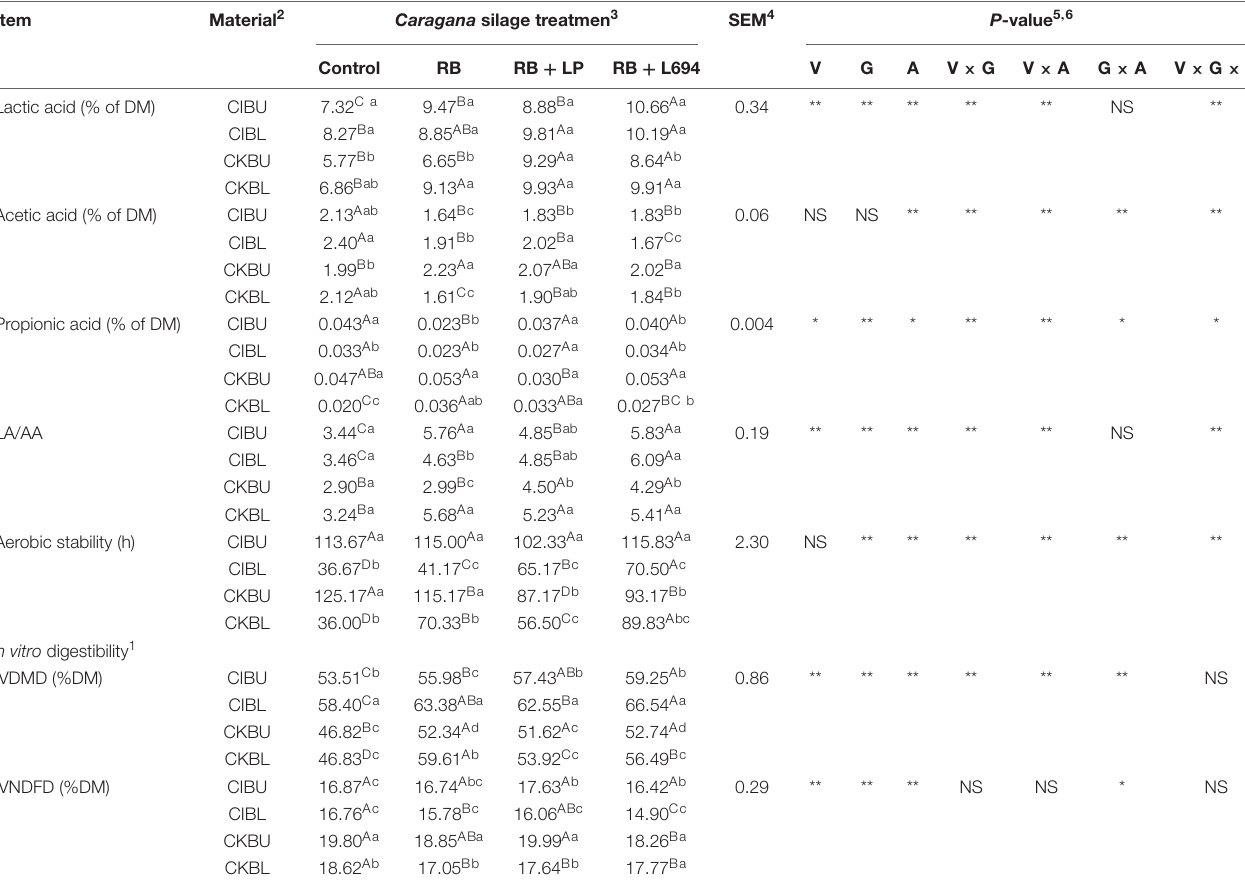
TABLE 2 | Fermentation quality, IVDMD, and IVDFD of Caragana silages prepared without and with RB and LAB at different growth stages ( n = 3). Item Material 2